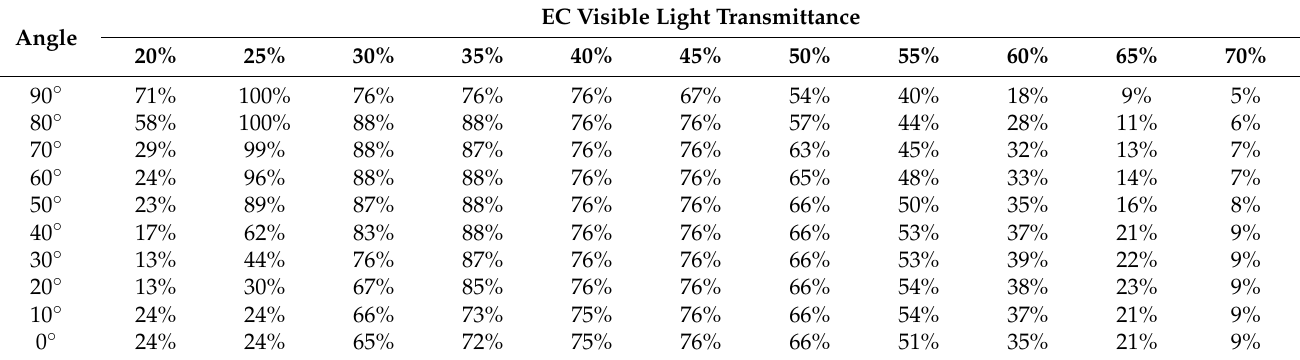
Table 8. Target illuminance achievement rates when the number of divisions of louvers is 14.